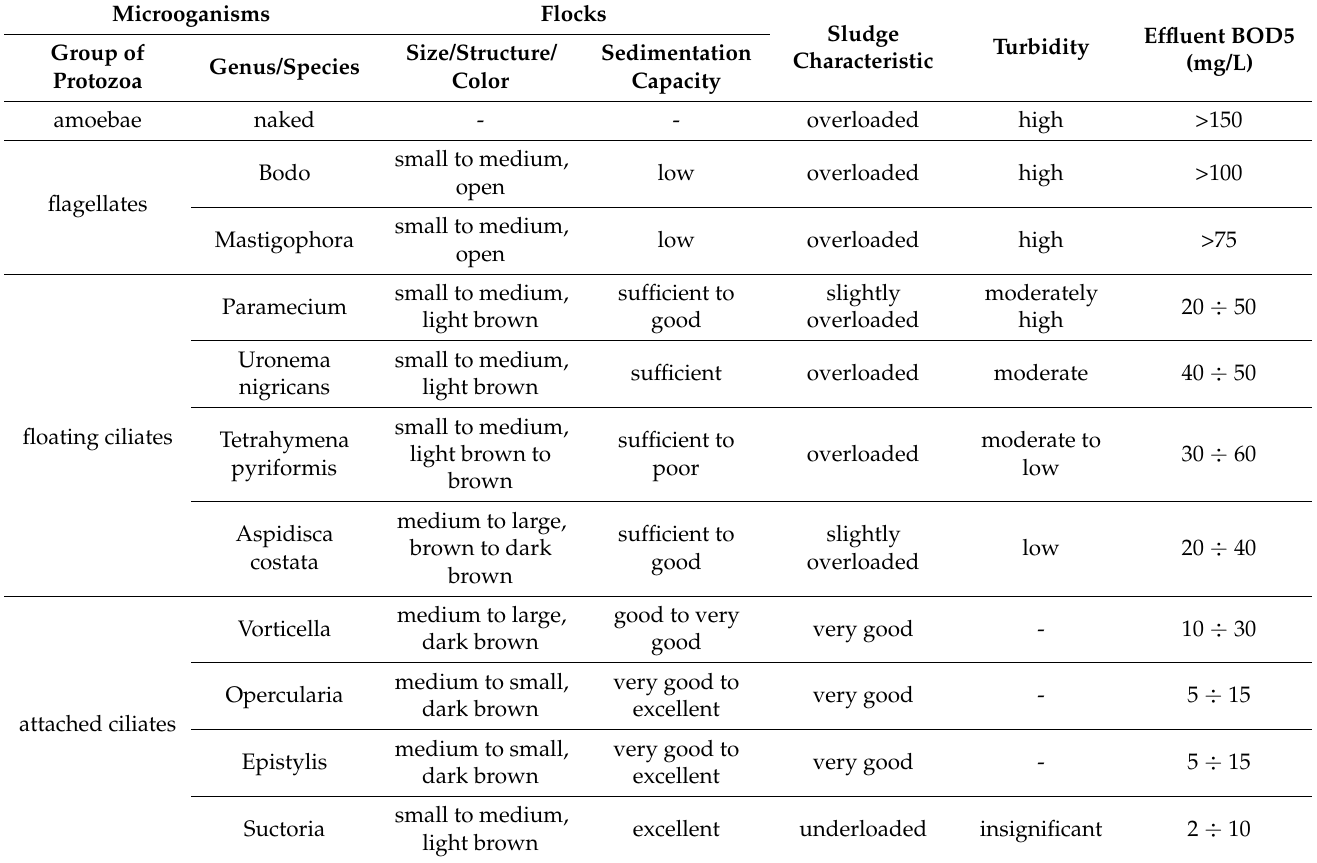
Table 1. Relationship between results of microscopic analysis and effluent quality